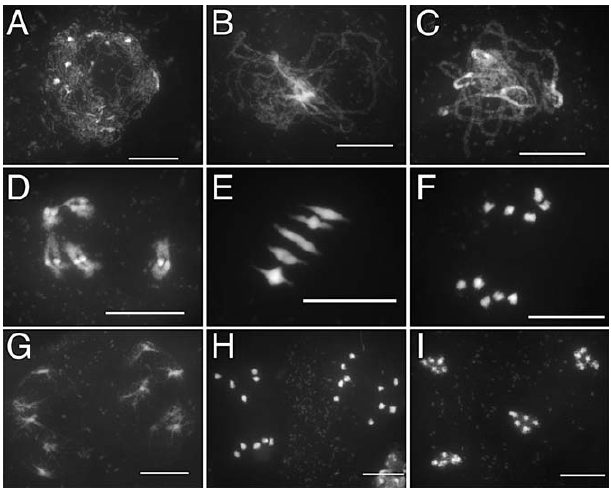
Figure 3. DAPI Staining of Wild-Type (Ws) PMCs during Meiosis (A) Leptotene, (B) zygotene, (C) pachytene, (D) diakinesis, (E) metaphase I, (F) end of anaphase I, (G) telophase I, (H) end of anaphase II, (I) end of meiosis. Bar, 10 l m.